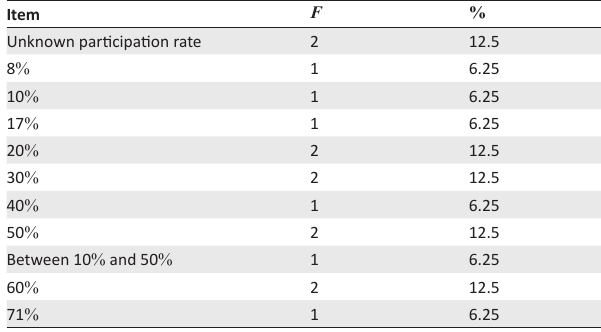
TABLE 8: Percentage of employees who participate in their organisation’s Employee Wellness